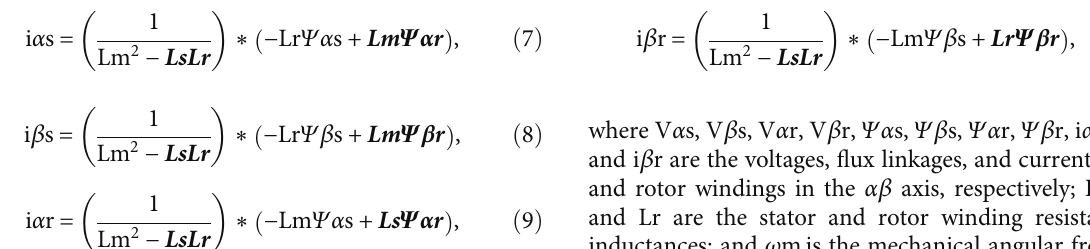
Figure 2: MATLAB